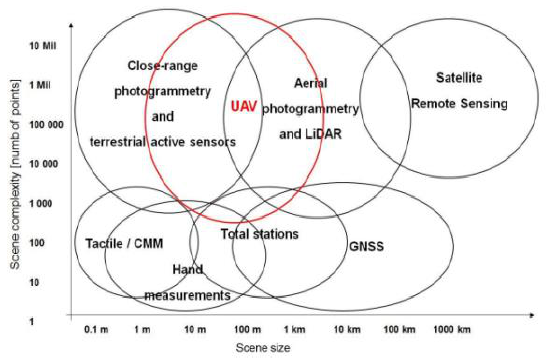
Figure 1. UAV photogrammetry place alongside other sub-branches of